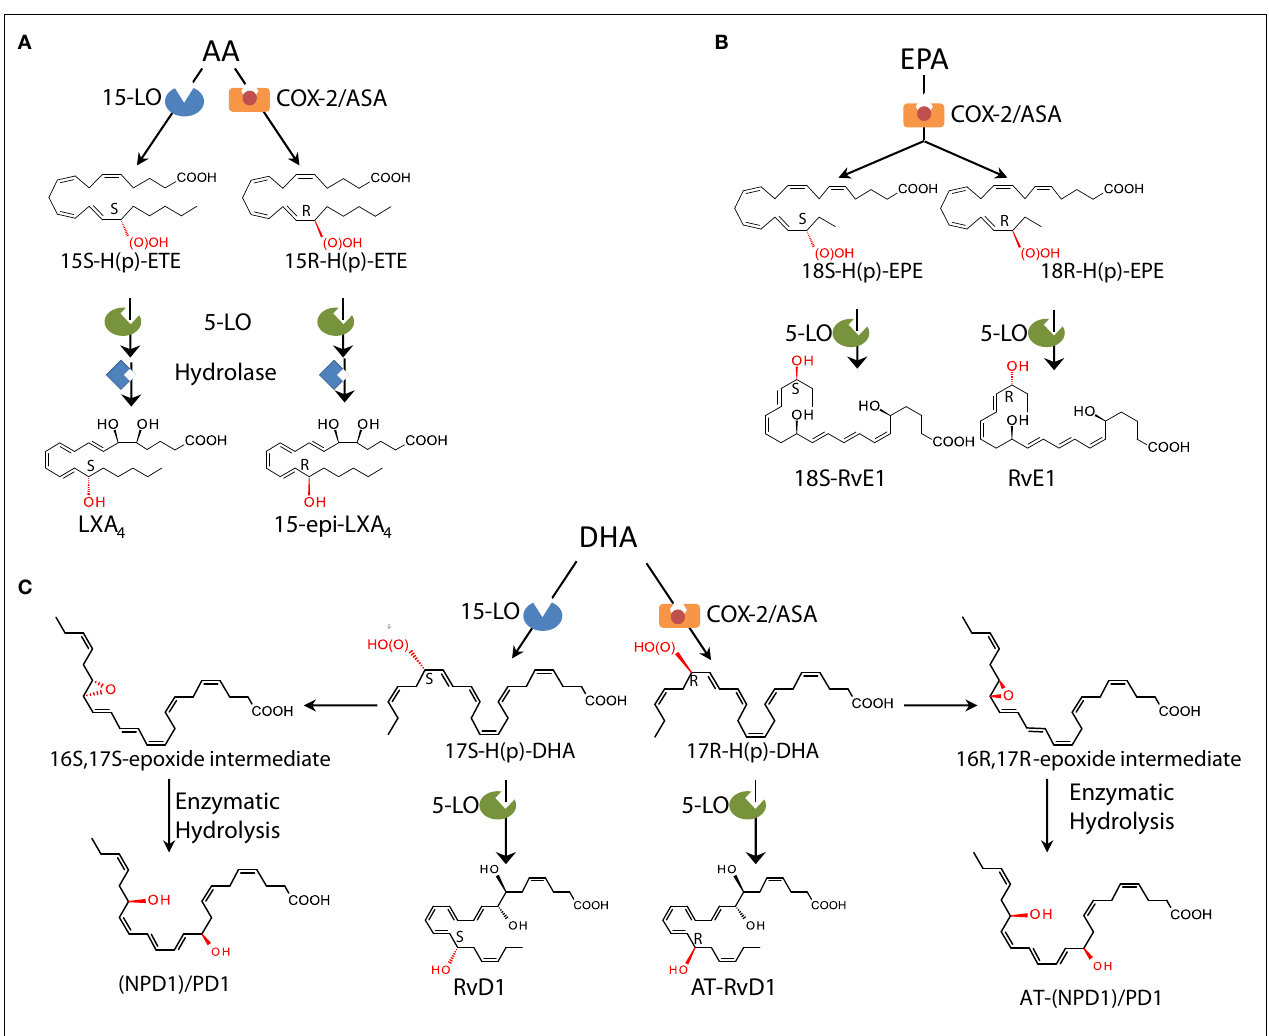
includes several SPM biosynthesized via 15/5-LO and ASA-acetylated COX-2. Each SPM is biosynthesized via distinct biochemical routes involving stereocontrolled oxygenation, epoxide formation, and enzymatic hydrolysis.The main structures of key SPM and their biosynthetic routes (with precursors and main enzymes involved) are depicted (see text and Serhan and Petasis, 2011 for further details).The complete stereochemistry of each of these SPM is established, total organic synthesis achieved, and bioactions